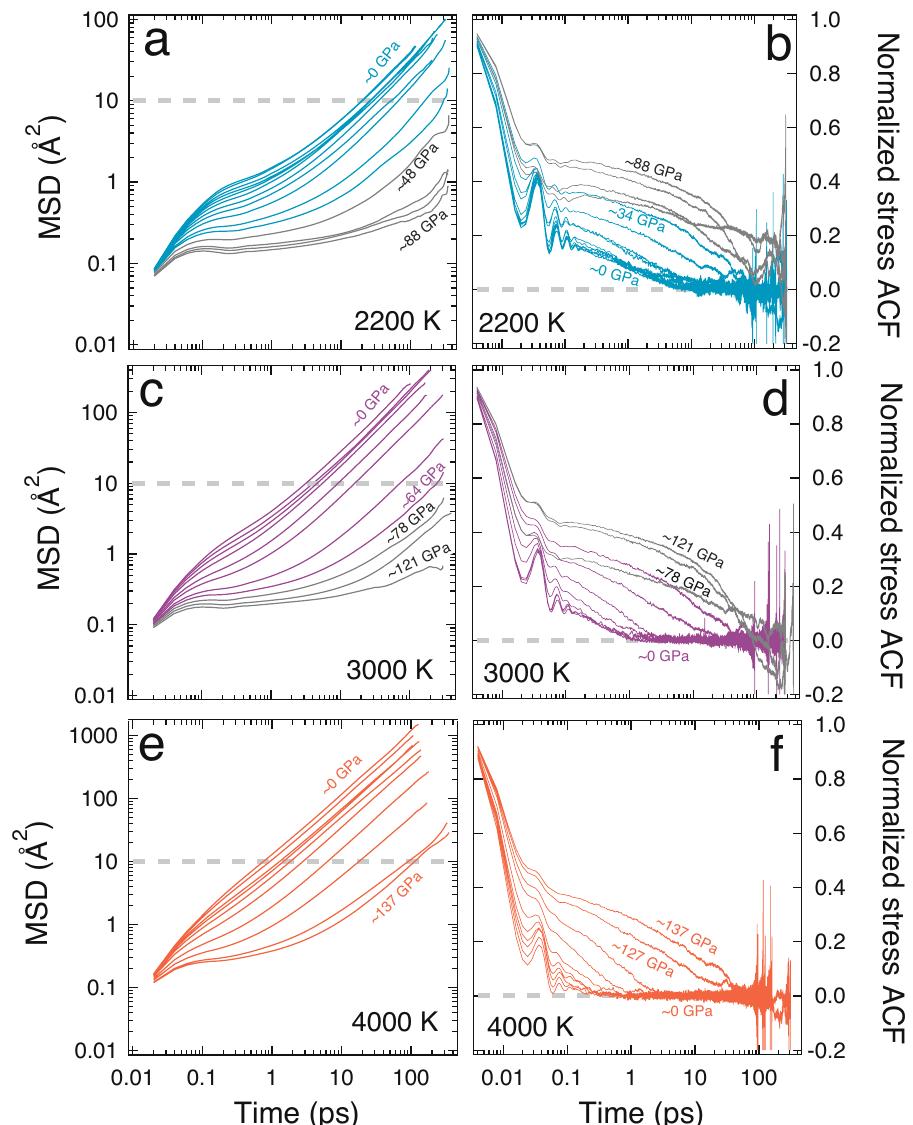
Fig. 2 | Mean square displacement and stress autocorrelation function of basaltic melt. Timeevolution of mean squaredisplacement (MSD) using Eq.3and normalized stress autocorrelation function (ACF) using Eq. 4 at 2200K ( a and b ), 3000K ( c and d ), and 4000K ( e and f ). In each MSD plot, the gray dashed lines